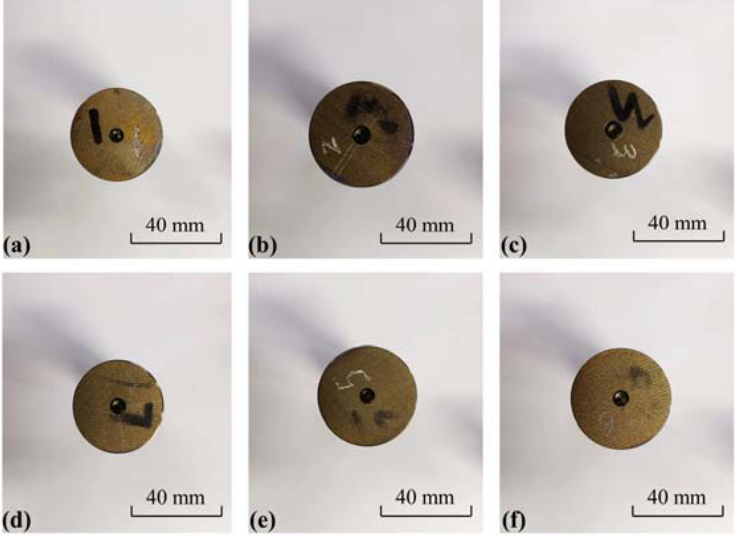
Figure 2. Picture of six aviation alloy samples. ( a ) 42CrMo; ( b ) A100; ( c ) GH4169; ( d ) TC4; ( e ) TC11; ( f ) TC17.